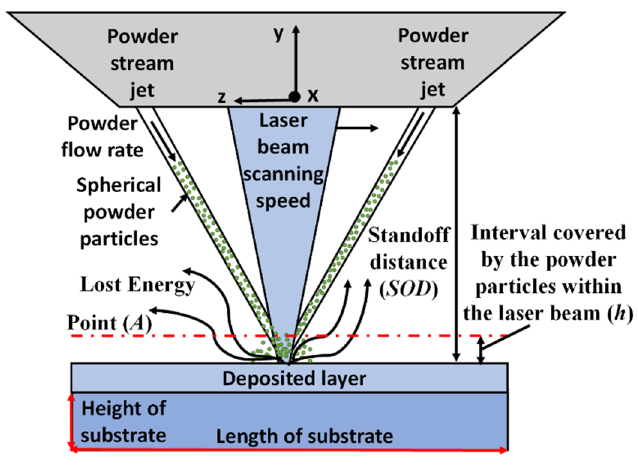
Figure 2. Schematic of the laser melting deposition (LMD) process.